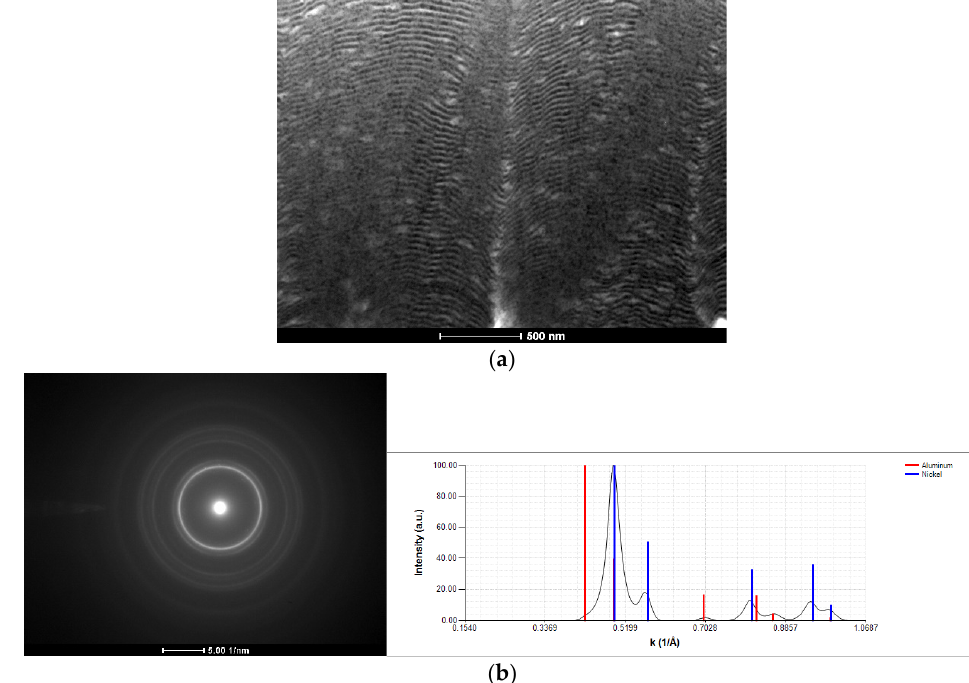
Figure 8. ( a ) BF TEM cross-section micrograph, and ( b ) SAED pattern and respective indexation of an Al/Ni thin film following ignition by mode I ( φ = 0.05 mm W wire).